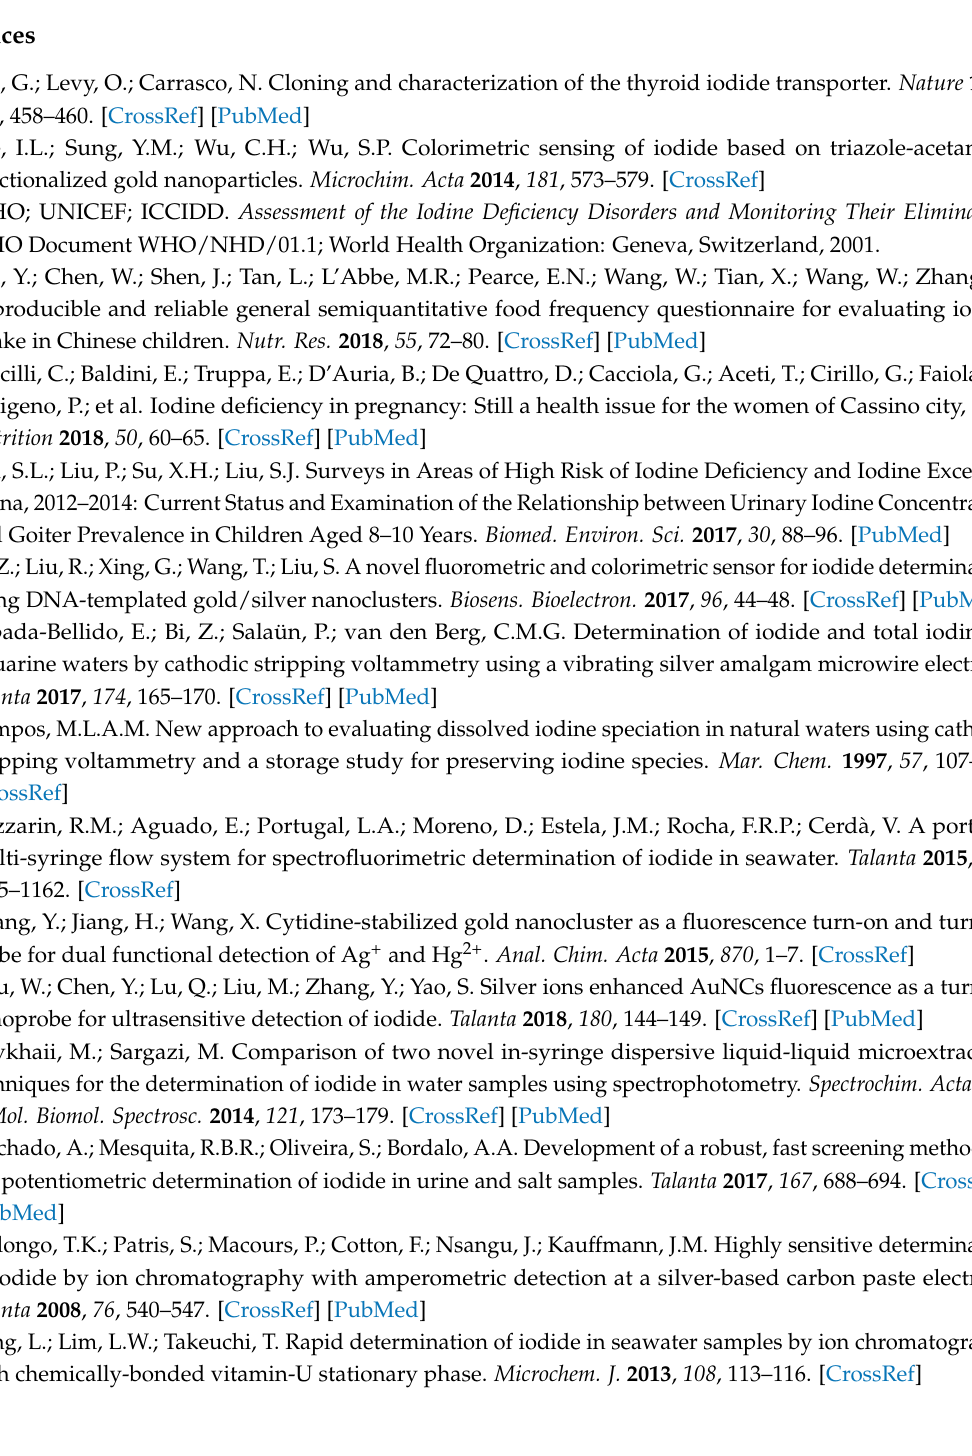
CQDS/AuNPs showing the peaks for C, O, Cu and Au. Table S1 Results for the determination of iodide in salt samples ( n = 3). Table S2: Comparison of the proposed iodide detection method with other reported